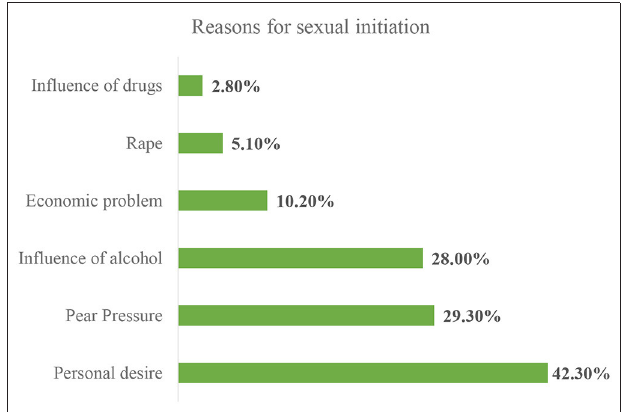
FIGURE 1 | Reasons for sexual initiation among private preparatory school students in Gondar city, northwest Ethiopia, 2019.